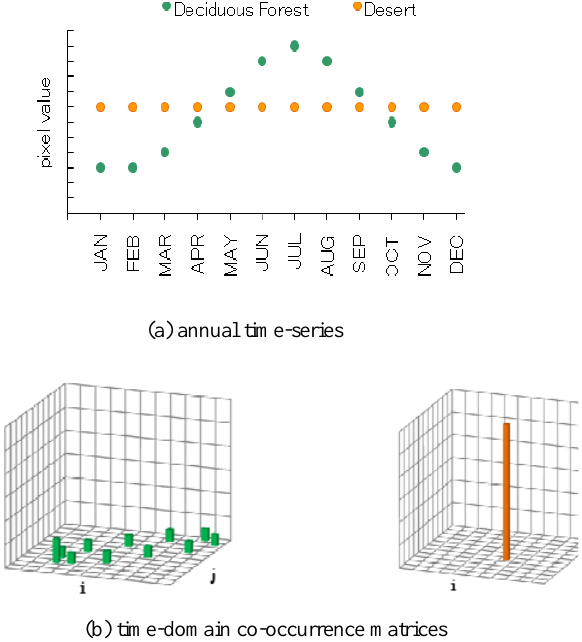
Figure 3. Conceptual examples of time-domain co- occurrence matrix.